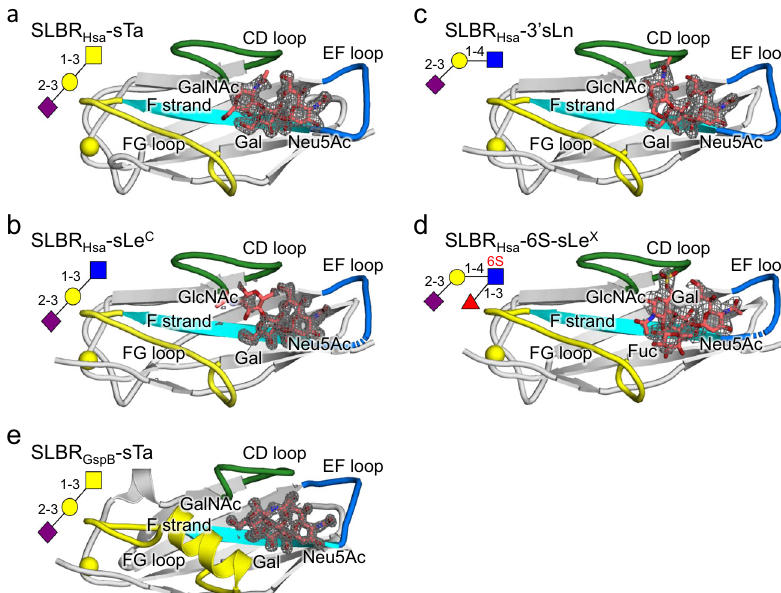
Fig. 4 Sialoglycans bound to SLBR Hsa and SLBR GspB . SLBR Hsa bound to sialoglycans a sTa, b sLe C , c 3 ’ sLn and d 6S-sLe X . e SLBR GspB-Siglec bound to sTa. In each panel, the SLBR is shown as a cartoon with the CD, EF, and FG selectivity loops colored in green , blue , and yellow respectively. The F strand contains the conserved YTRY motif and is shown in cyan . Ions are shown in yellow spheres. Carbon atoms of each sialoglycan are colored salmon with nitrogen shown in blue and oxygen in red . |F o | − |F c | difference electron density calculated after removing the sialoglycan and performing three rounds of re fi nement in Phenix 55 are shown in gray mesh and contoured at 3 σ . The standard depiction for each carbohydrate is shown in the upper left, with linkages indicated.